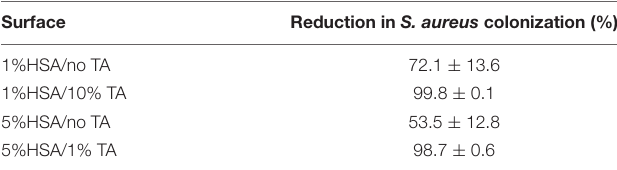
TABLE 2 | Reduction in S. aureus colonization (%) on treated scaffolds. Surface Reduction in S. aureus colonization